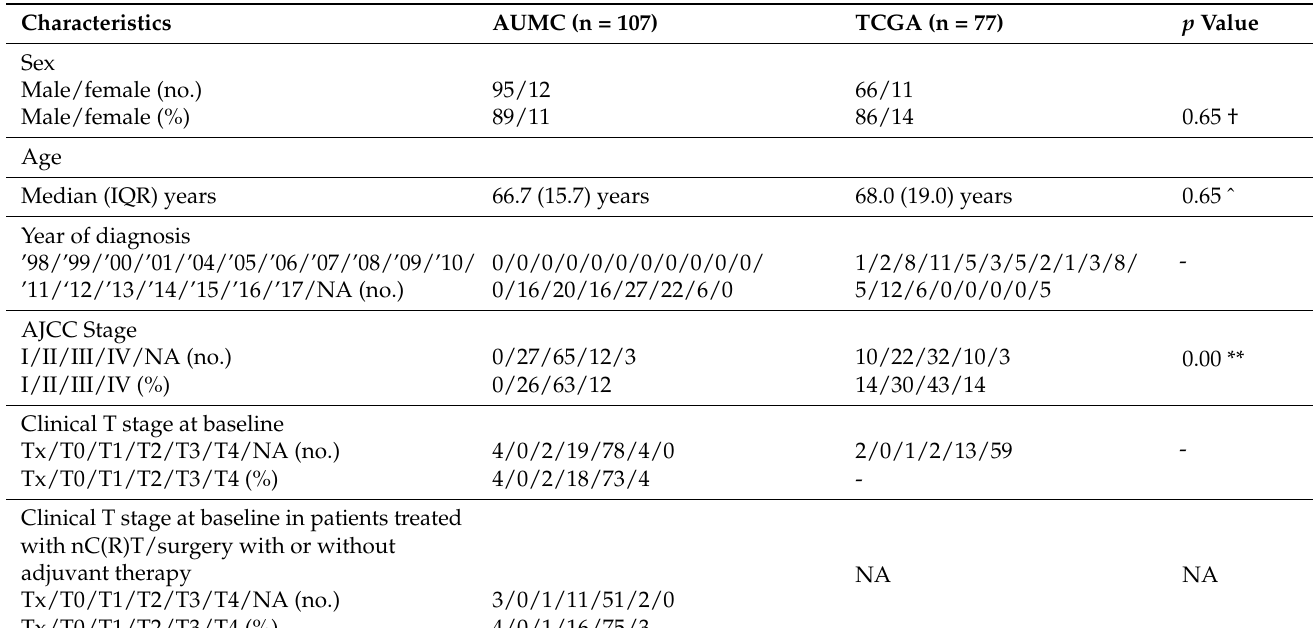
Table 1. Baseline characteristics of AUMC (discovery cohort) and TCGA